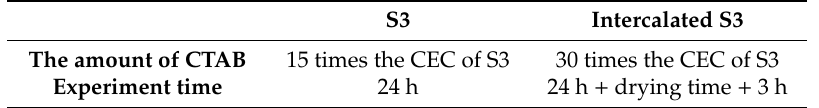
Table 2. The usage of reagents and experiment time with different raw materials for the intercalation.